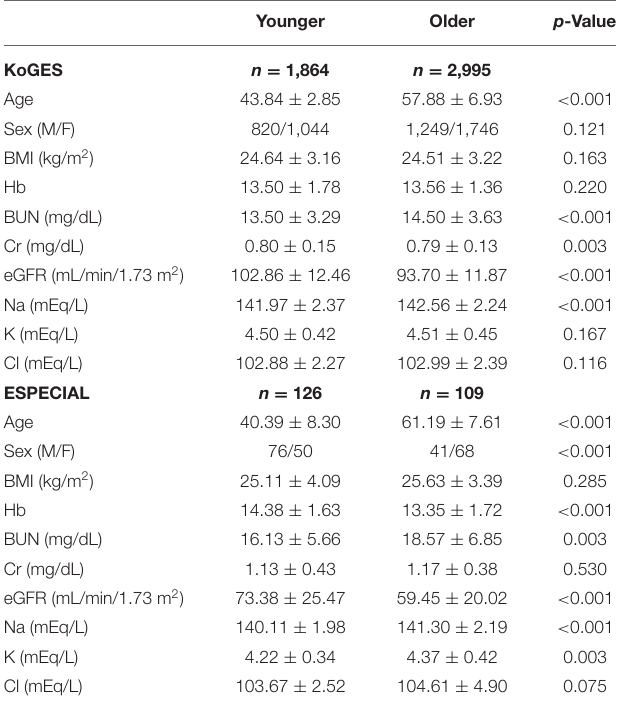
TABLE 1 | Baseline characteristics of participants in the KoGES and ESPECIAL